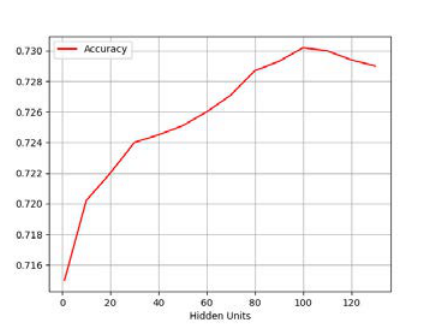
Fig. 5. The accuracy of the sensor network